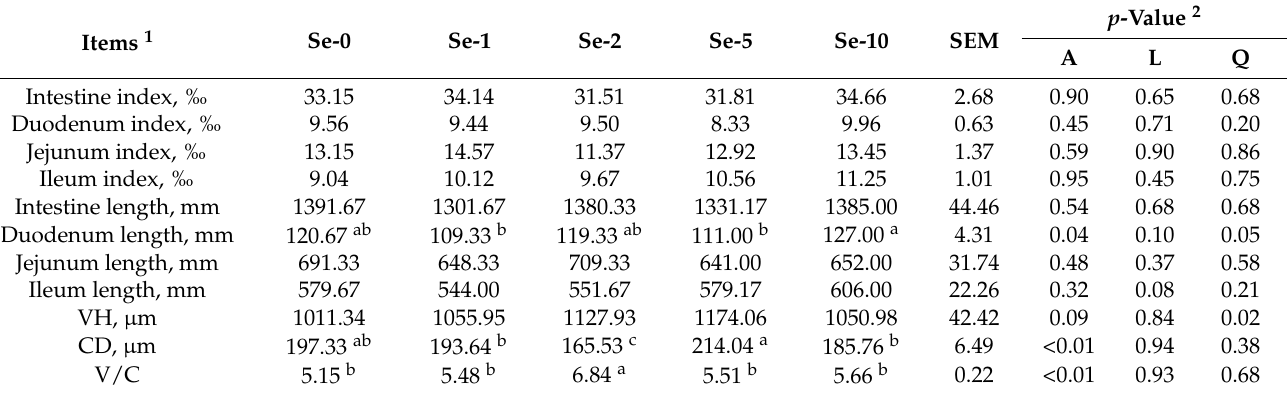
Table 9. Effects of dietary organic selenium on intestinal development of laying